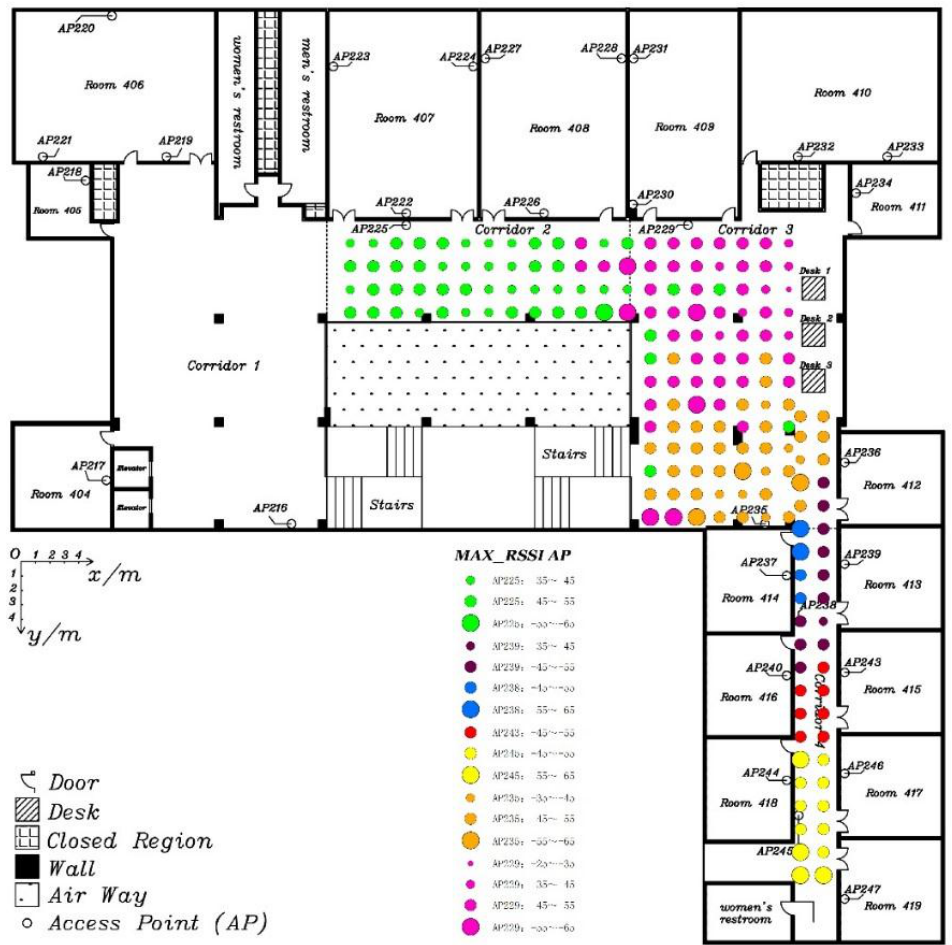
Figure 13. Strongest AP distribution in experimental area.